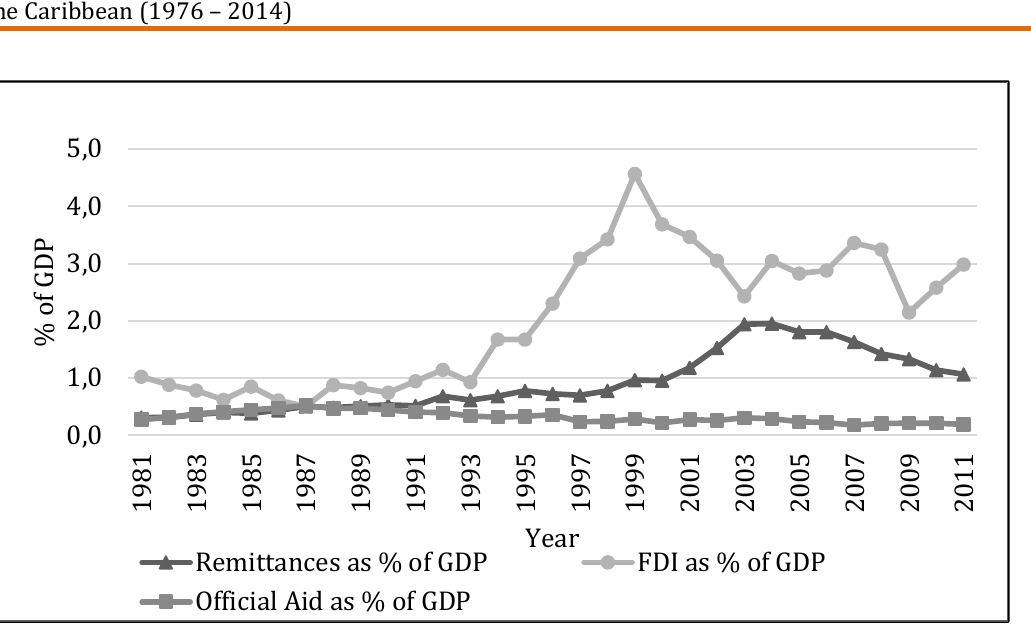
Source: World Development Indicators, World Bank